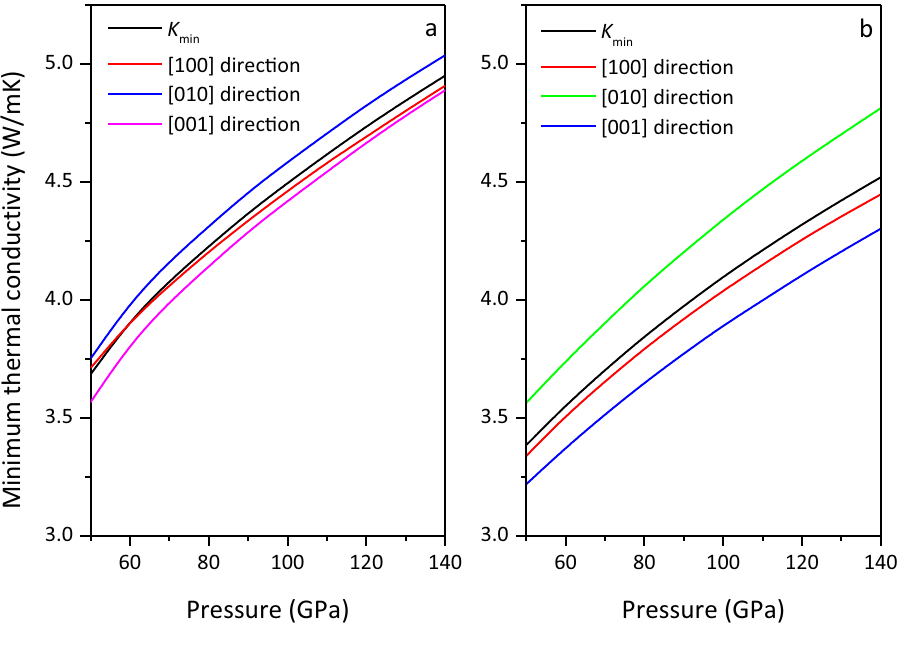
Figure 12. Minimum thermal conductivity of MgCO 3 - C 2 /m ( a ) and Mg 2 CO 4 - P 2 1 /c ( b